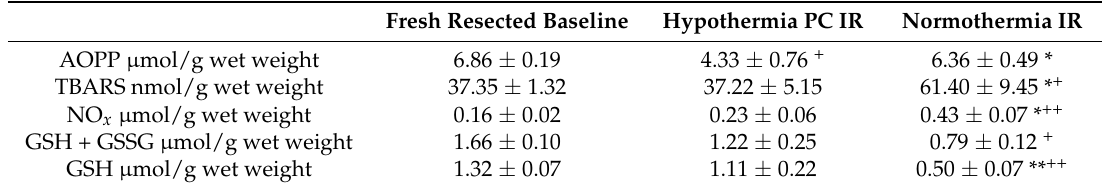
Table 1. Effect of hypothermic preconditioning on oxidant/antioxidant parameters in liver after ex vivo warm ischemia